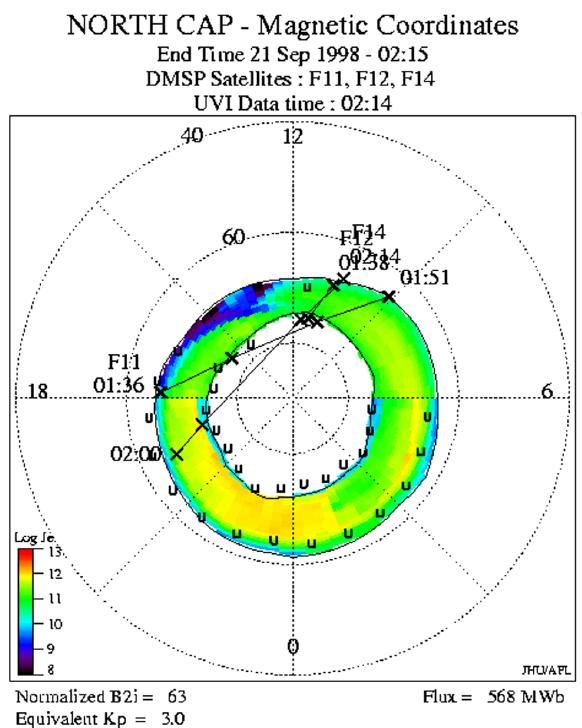
Plate 1 : Example of an OVATION display with DMSP data and Polar UVI data. The DMSP boundaries are marked with an “x”, while the Polar UVI boundaries are marked with an “U”. The total integrated polar cap flux is in megawebers. The equivalent instan- taneous K p is calculated from a linear fit to b 2 i data.